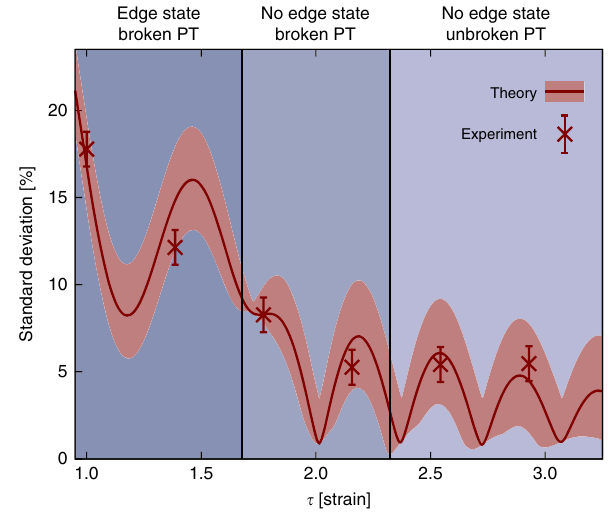
Fig. 3 Demonstration of the phase transition from broken to unbroken PT -symmetry. The standard deviation of the output intensity pattern resulting from 6 excitations (3 unit cells). In the unbroken PT -symmetric phase, this quantity approaches zero. The simulations are performed by using the Schrödinger equation in the tight binding limit Eqs. (4a) and (4b). The red shaded area represents the calculated uncertainty arising from possible unequal incoupling in the experiment, whereas the error bars account for fl uctuations of the measured data. The blue shaded regions show the three distinct phases associated with the strain and loss parameters of our structure (see Fig.